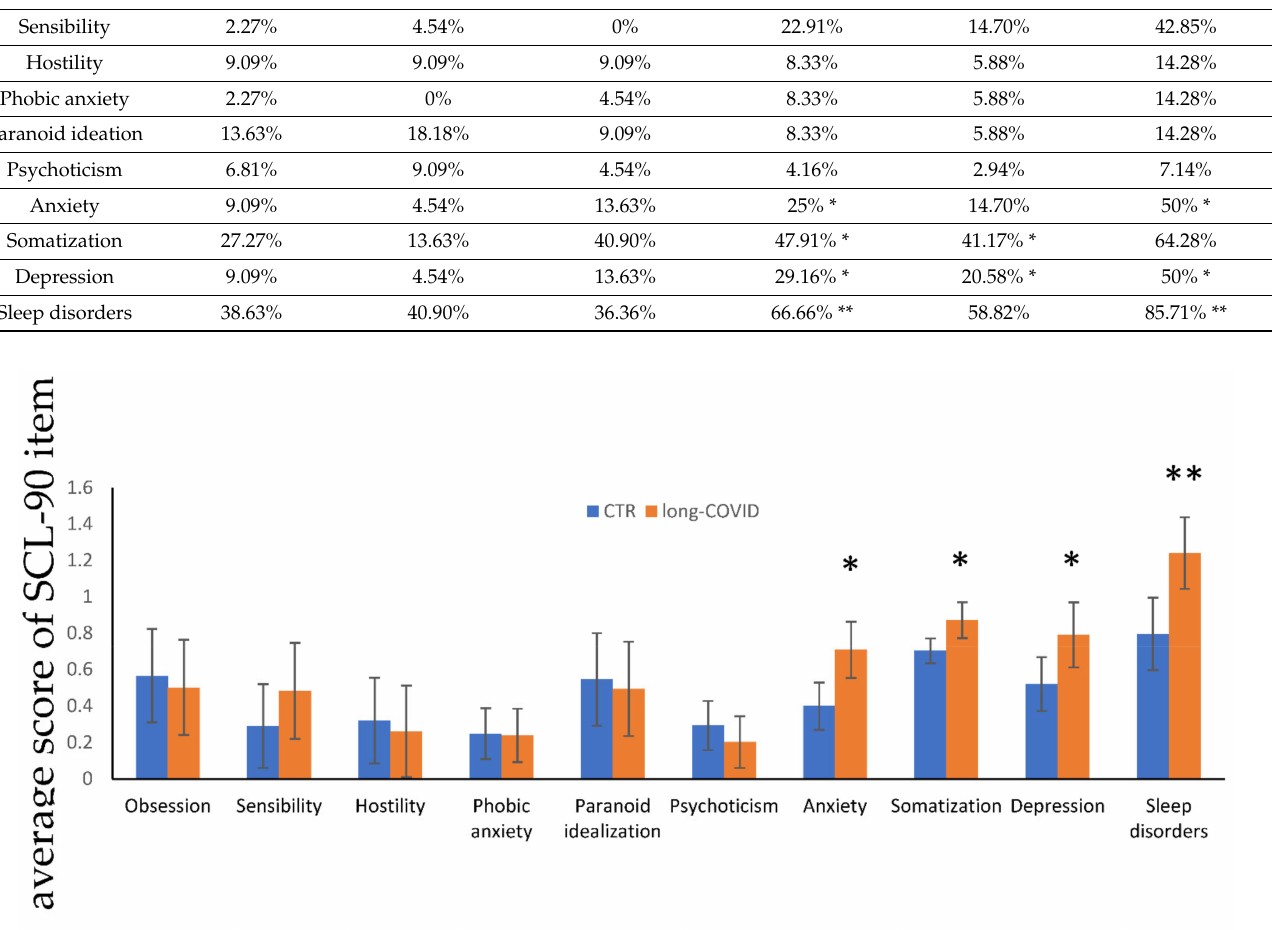
Figure 1. Psychological parameters analyzed by SCL-90 test. Values are expressed as means ± SD and data were analyzed by a t -test analysis (* p < 0.05; ** p <